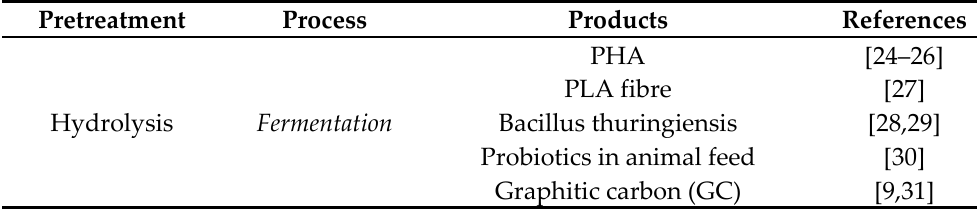
Table 2. Reported experimental (laboratory-scale) conditions for polyhydroxyalkanoate (PHA), biopesticide, and other high-value product production (extraction) from OFMSW-derived